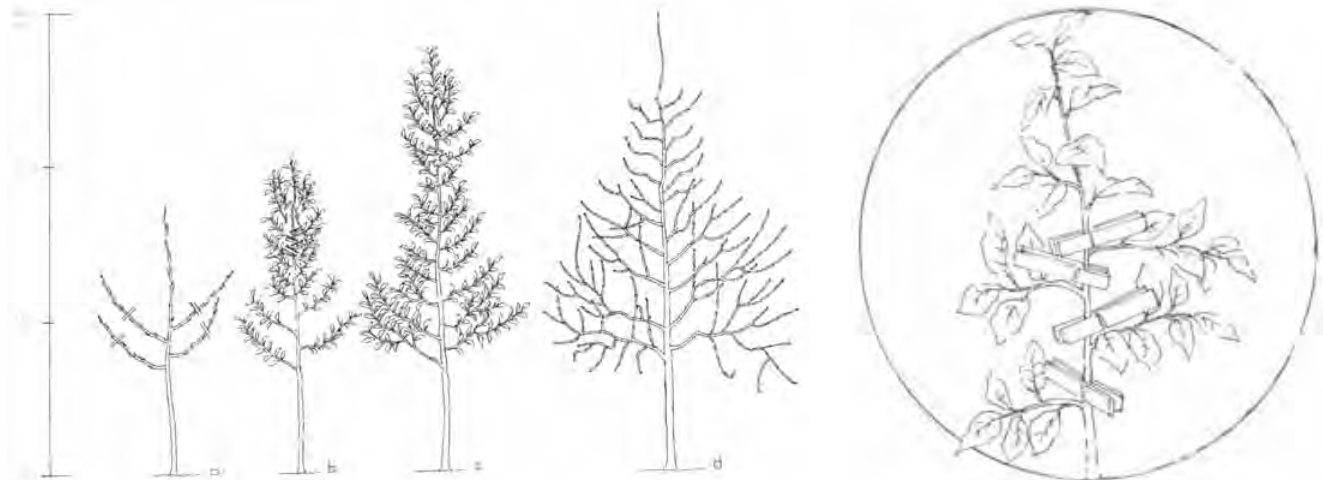
Fig. 1 - Plum tree training with summer pruning: a) planted feathered tree is left with unheaded central leader and lightly headed side shoots; b) in May side shoots appearing at top of the leader are cut off except for one left for leader prolongation, some lower shoots are bent with clips; c) treatments at top of the leader are repeated in May of the second year; d) tree with fruiting ability in spring of the third year; e) shoot bending with a clip.